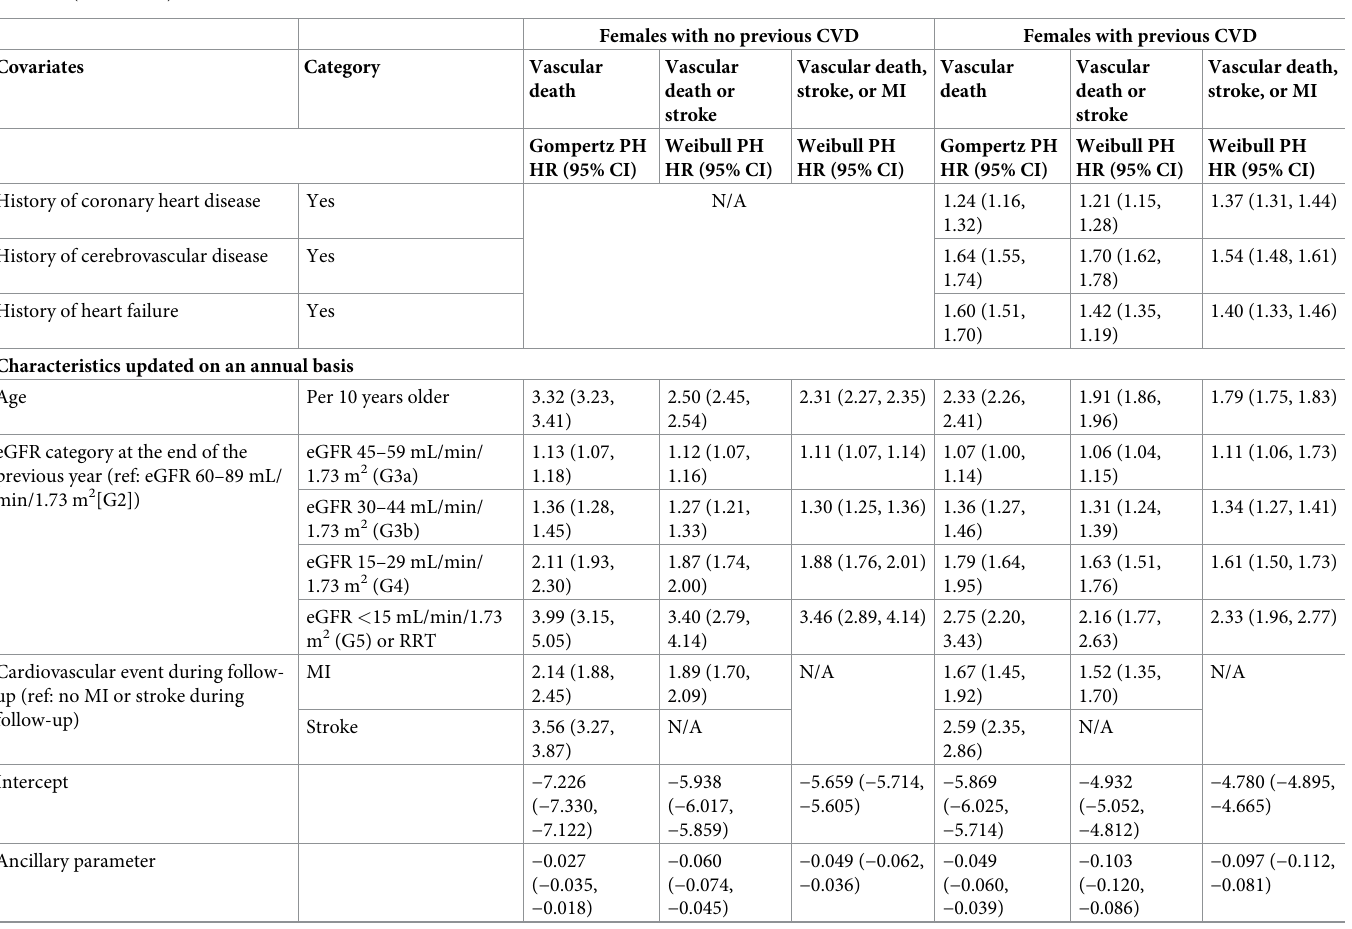
Application 1: Predicting life expectancy of patients with reduced kidney function. The model predicted large variation in survival by eGFR category at cohort entry (Fig 3, Table I in S1 Text). Among patients aged 60 to 69 in G2, those without previous CVD were predicted to live a further 22.1 years (16.1 quality-adjusted life years [QALYs]) and those with CVD a further 18.6 years (11.8 QALYs). The corresponding values for patients in G5 not on RRT were 13.7 years (9.2 QALYs) and 10.1 years (5.7 QALYs), respectively. Application 2: Quantifying the impact of partial and optimal use of cardiovascular pre- vention medications in patients with reduced kidney function. Fig 4 and Table J in in S1 Text summarise the benefits of statins, antihypertensives, and antiplatelets by patient’s age, eGFR category, and history of CVD at cohort entry. Using NICE recommendations in 2019, the proportions of patients indicated for treatment who were prescribed statin, antihyperten- sive, or antiplatelet in 2013 would be 37% among those without previous CVD and